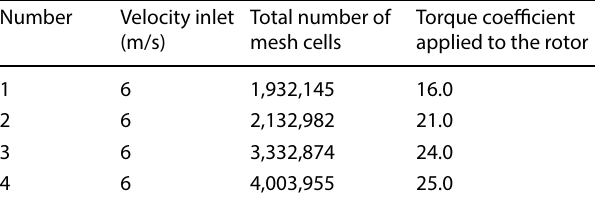
Table 2 Results for grid independence checking